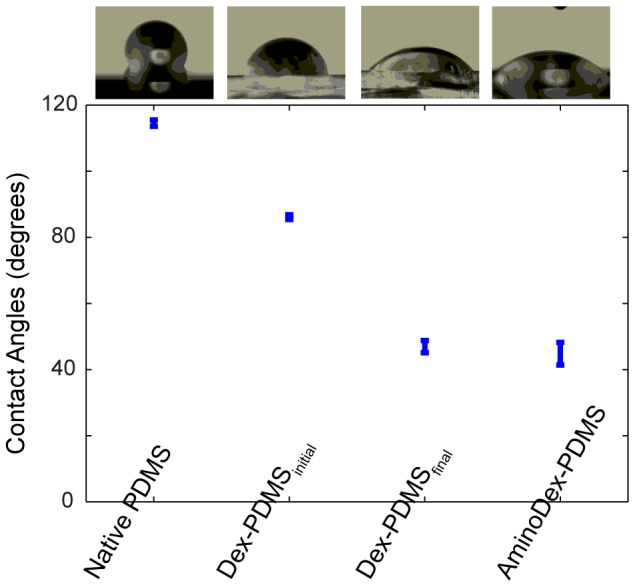
Contact angle of various formulations of dextran-PDMS.Introduction of dextran onto the PDMS surface increases the wetting of the substrate, depending on formulation of PDMS, and absorption of water into the embedded dextran.